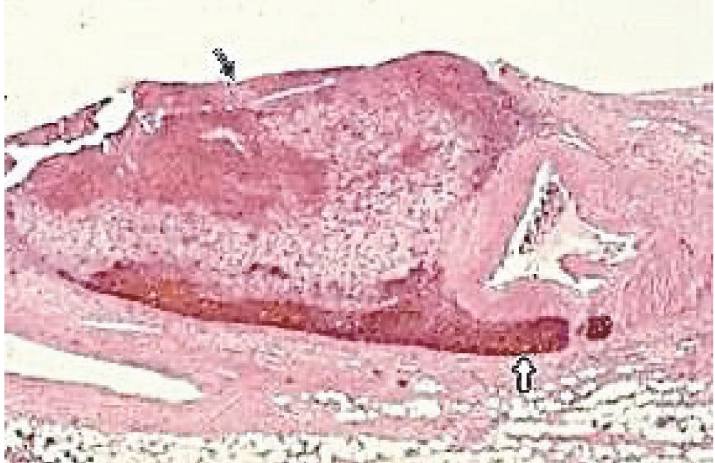
Figure 15: Segmental arterial mediolysis reparative phase. Early reparative phase. The black arrow points to a fl orid proliferation of young granulation tissue developing in the tear space between the outer media and adventitia. Bleeding from injured capillaries has initiated hematoma formation. The white arrow points to a beginning dissection between the outer media and adventitia. Hematoxylin & eosin